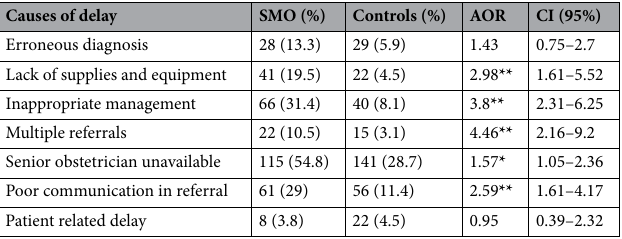
Table 5. Major causes of delay and their association with maternal outcome among women admitted to Keren Hospital. *Significant at p = 0.05.